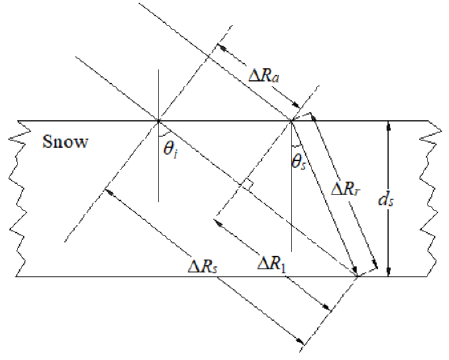
Figure 6. Schematic diagram of radar wave penetrating snow.